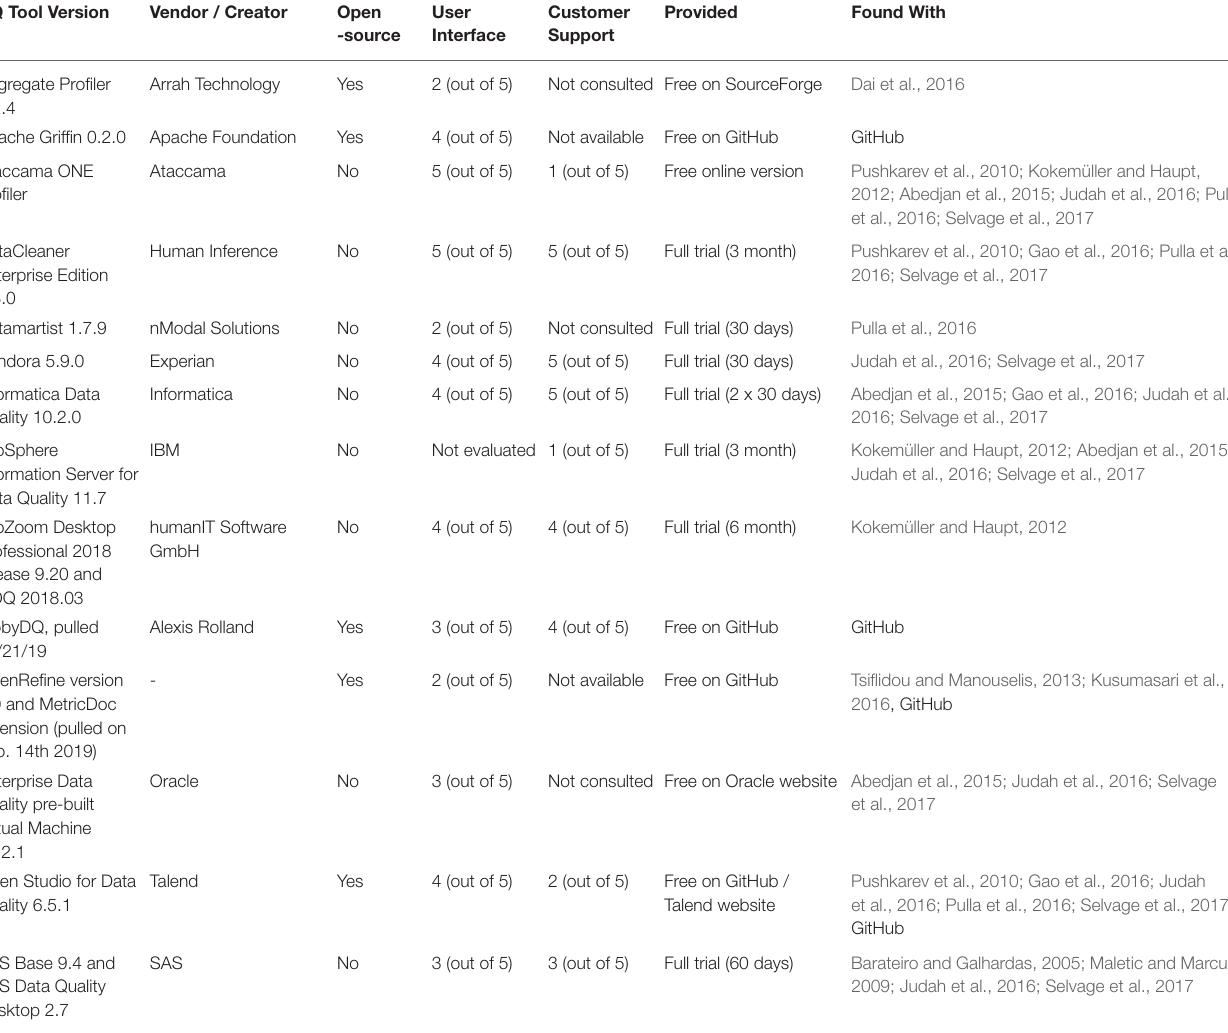
TABLE 4 | Summary of investigated DQ